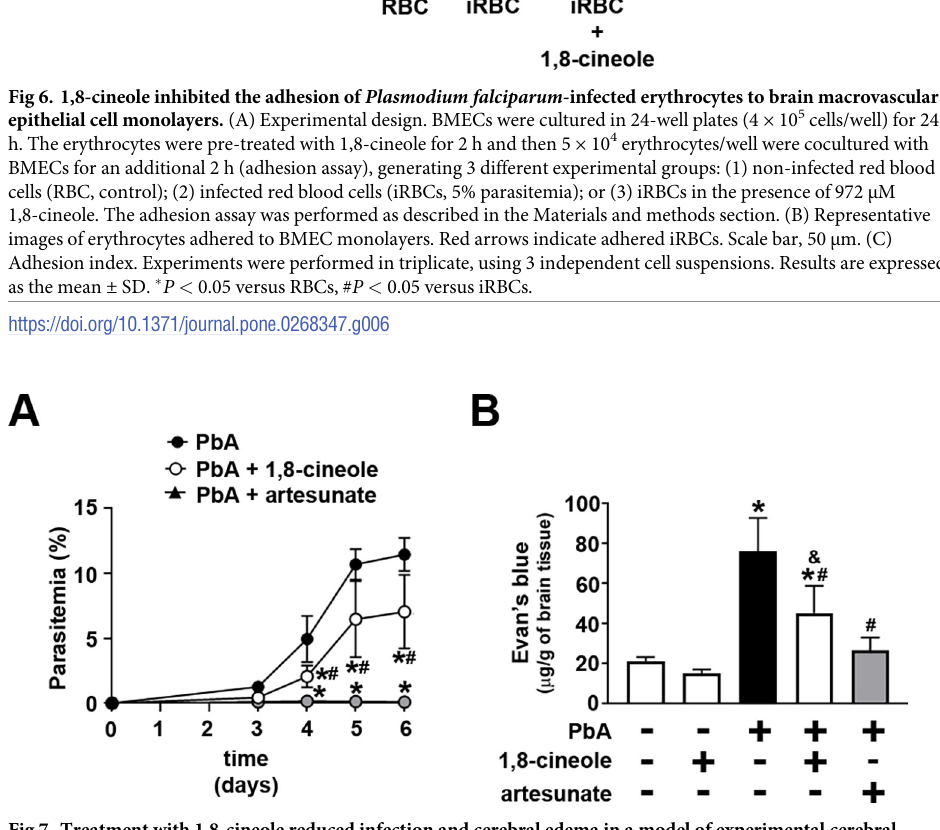
Fig 7. Treatment with 1,8-cineole reduced infection and cerebral edema in a model of experimental cerebral malaria. C57BL/6 mice were infected with P . berghei ANKA (PbA) before treatment with 100 mg/kg/day of 1,8-cineole or 10 mg/kg/day of artesunate via intraperitoneal injection for 6 consecutive days. (A) Peripheral blood parasitemia was determined in hematologic stained thin blood smears by optical microscopy ( n = 5). As depicted, parasitemia was determined at days 3, 4, 5 and 6 post-infection. (B) Assessment of cerebral edema ( n = 4). At day 6 post-infection, cerebral edema was assessed by Evans blue dye extravasation assay as described in the Materials and methods section. The results are expressed as the mean ± SD. (A) � P < 0.05 versus PbA; # P < 0.05 versus PbA + artesunate. (B) � P < 0.05 versus control mice (non-infected mice); # P < 0.05 versus PbA; & P < 0.05 versus PbA + artesunate.